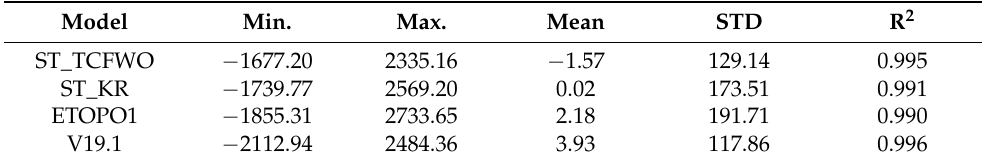
Table 5. The difference statistical results of seafloor topography model, namely the difference between four models and the check points of the shipborne depth measurements. (unit: m). Model Min. Max. Mean